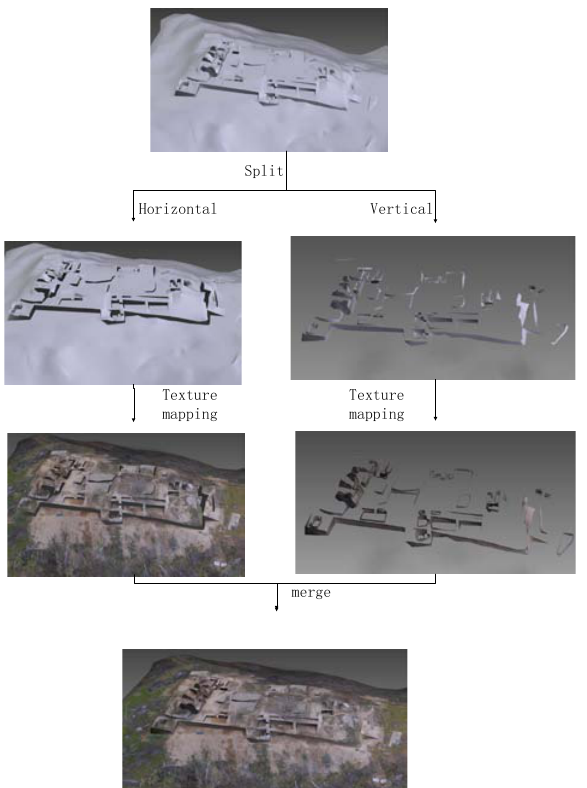
Figure 5: Split and merge texture